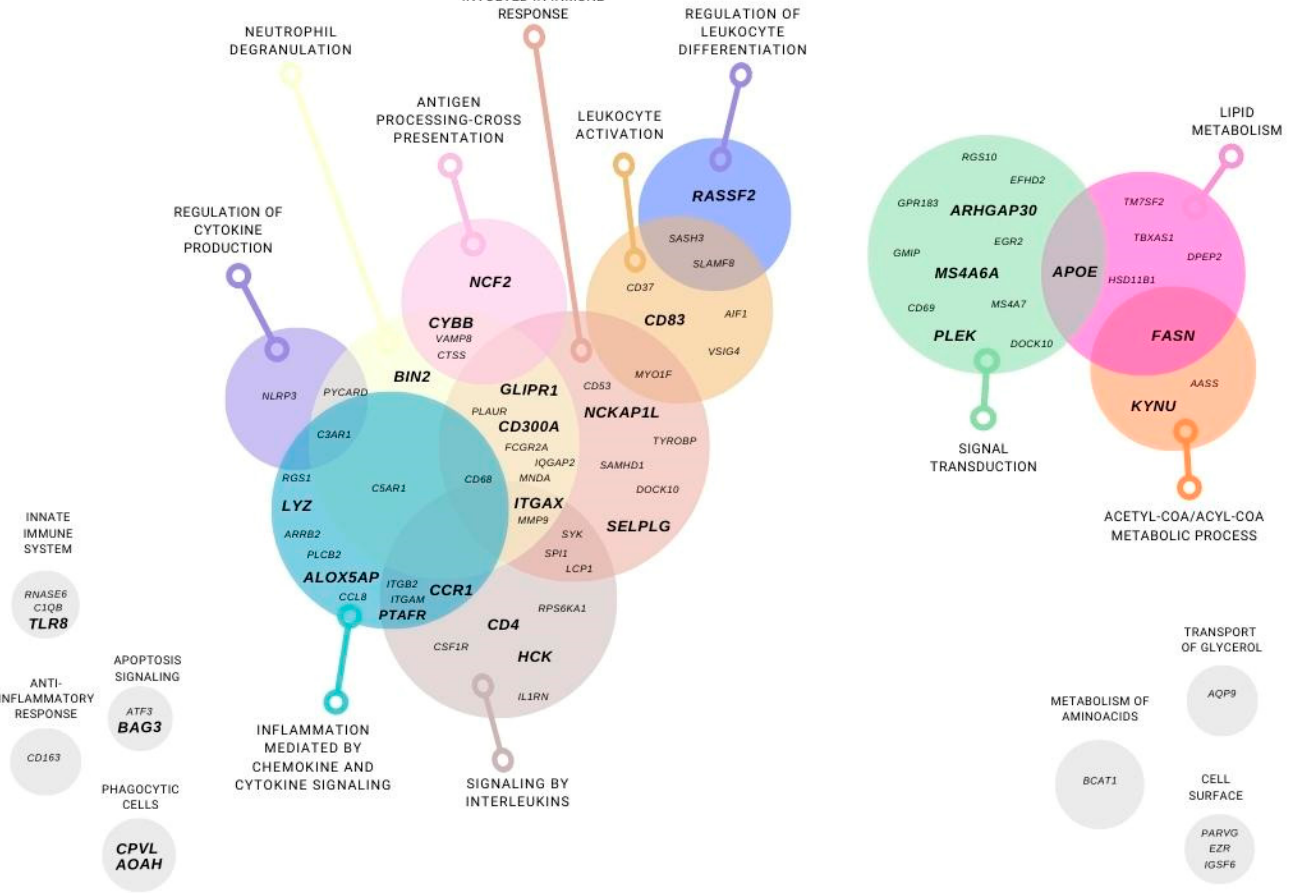
Figure 4. Subcutaneous adipose tissue differentially expressed genes using a transcriptomic gene approach. Genes that were differentially expressed in at least two microarrays in post‑RYGB vs. obese and were found in lean vs. obese are represented. Gene classification by function: lipid and aminoacid metabolism, glycerol transport, acetyl-COA and acyl-COA metabolic process, cell sur- face, signaling transduction, apoptosis signaling. In addition, inflammation and immune system pathways such as: anti-inflammatory response, innate immune system, inflammation mediated by chemokine and cytokine signaling, interleukins signaling, leukocyte activation and involve in im- mune response, regulation of leukocyte differentiation, antigen processing cross presentation, neu- trophil degranulation, phagocytic cells, and regulation of cytokine production.